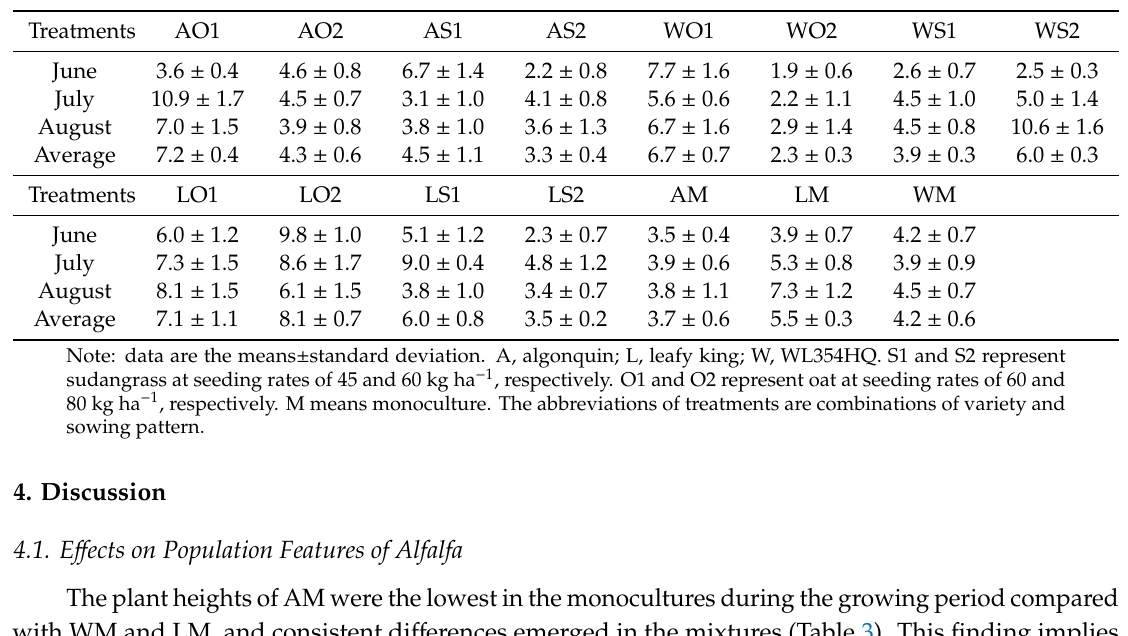
Figure 2. The percentage of coverage among all treatments during the growing season (mean ± SE). The three columns in each treatment represent the coverage proportion of June, July and August. The abbreviations are the same as above.